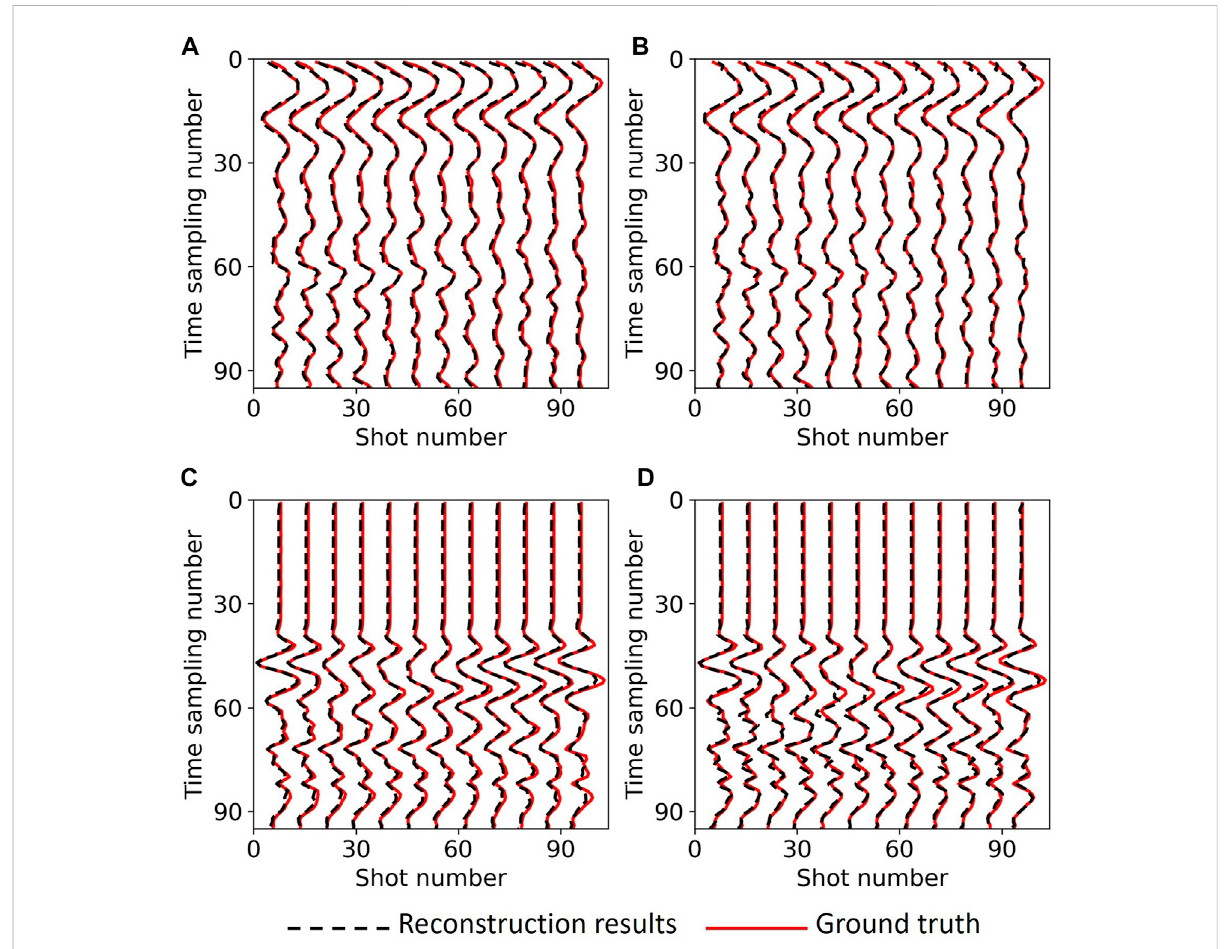
FIGURE 15 Wiggleplotson fi elddata: (A) No.49receiversliceofUnet, (B) No.49receiversliceofDS-Unet, (C) No.24receiversliceofUnet(Figure14C),and (D) No.24 receiver slice of DS-Unet (Figure 14D); black dashed lines indicate reconstruction results, and red solid line, ground truth.